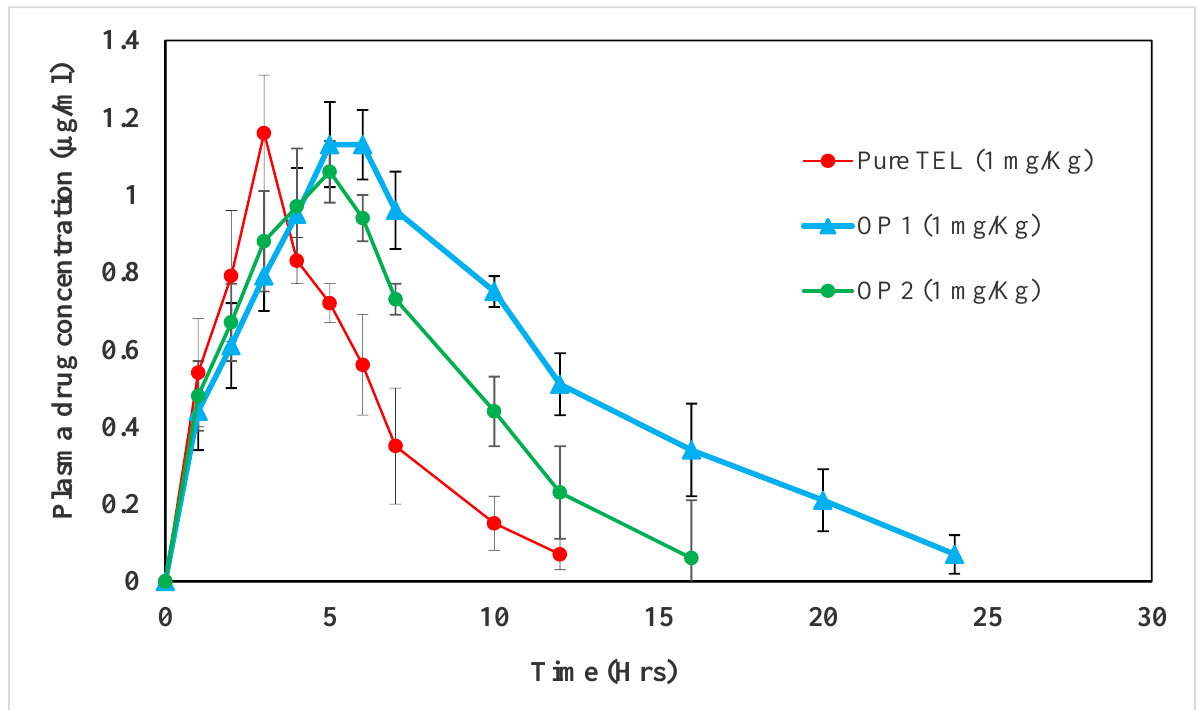
Figure 12. Plasma-concentration-time curve after oral administration of pure TEL, OP1, and OP2. Table 10. The pharmacokinetic parameters of TEL, OP1, and OP2.